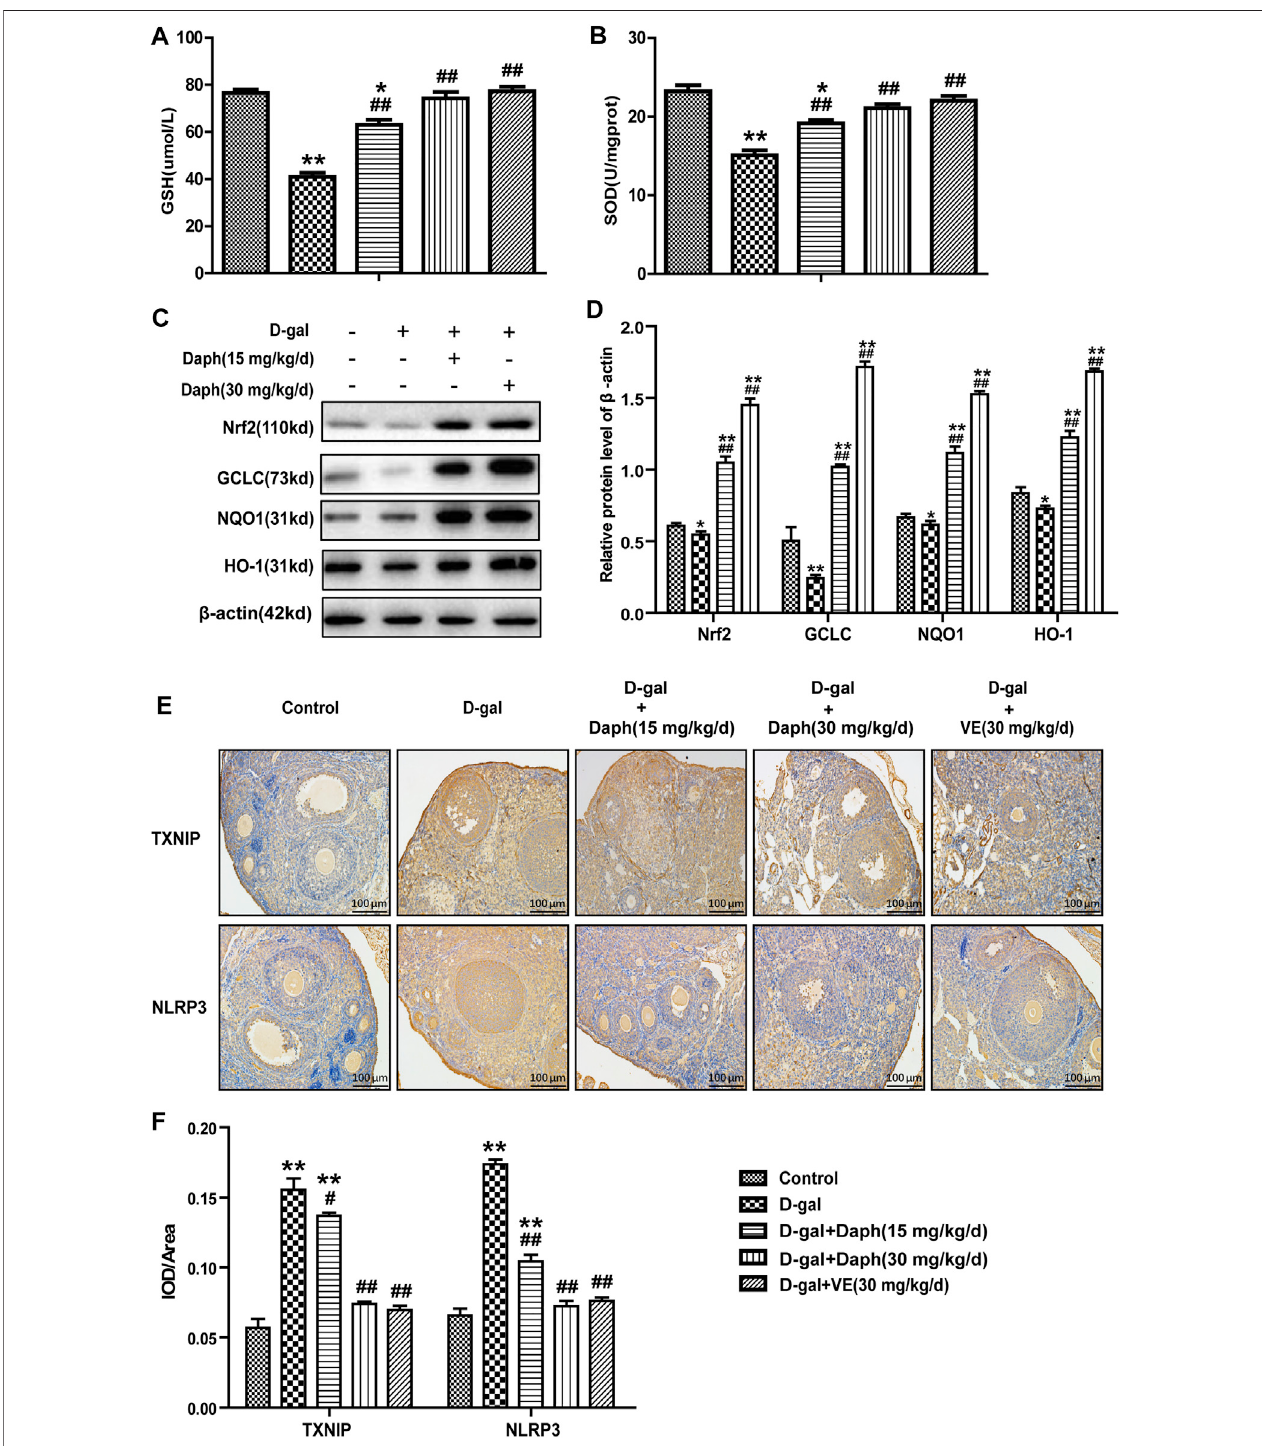
FIGURE 5 | Effect of Daph on oxidative stress-related pathways in the ovary. (A,B) The total SOD enzyme activity and the GSH level were measured in ovarian tissues. (C) The levels ofNrf2, GCLC, NQO1and HO-1 protein expression in ovarian tissues were observed via Western blotting. (D) The protein expression levels were quantitatively analyzed. (E,F) TXNIP and NLRP3 protein expression in the fi ve groups using IHC staining. All data are shown as means ± SEMs, n = 5, besides (C,D) which data are shown as means ± SEMs, n = 3. Statistical signi fi cance: * p < 0.05, ** p < 0.01, # p < 0.05, ## p < 0.01.